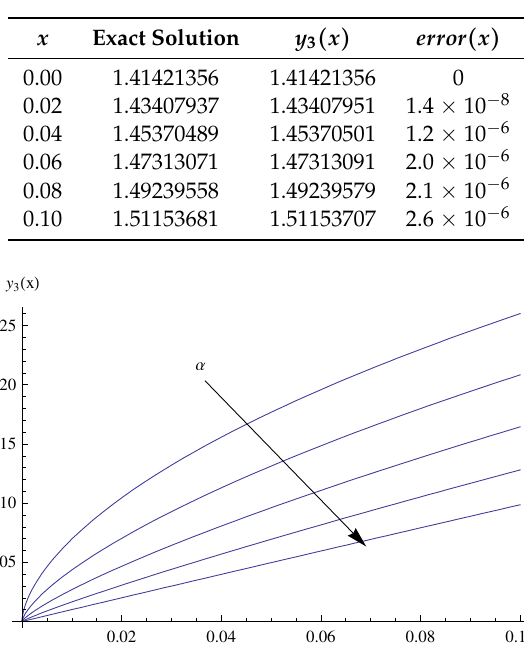
Table 3. Error when α = 1.